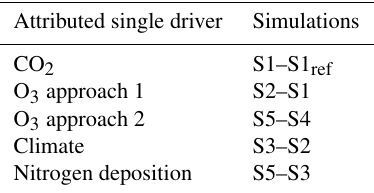
Table 2. Calculation of the single driver effects (CO 2 , climate, ni- trogen deposition, and O 3 ) from the conducted simulations. S1 ref refers to the mean of the years 1850 to 1859 of the S1 simulation. See Table 1 for information on the forcing setting of the factorial runs